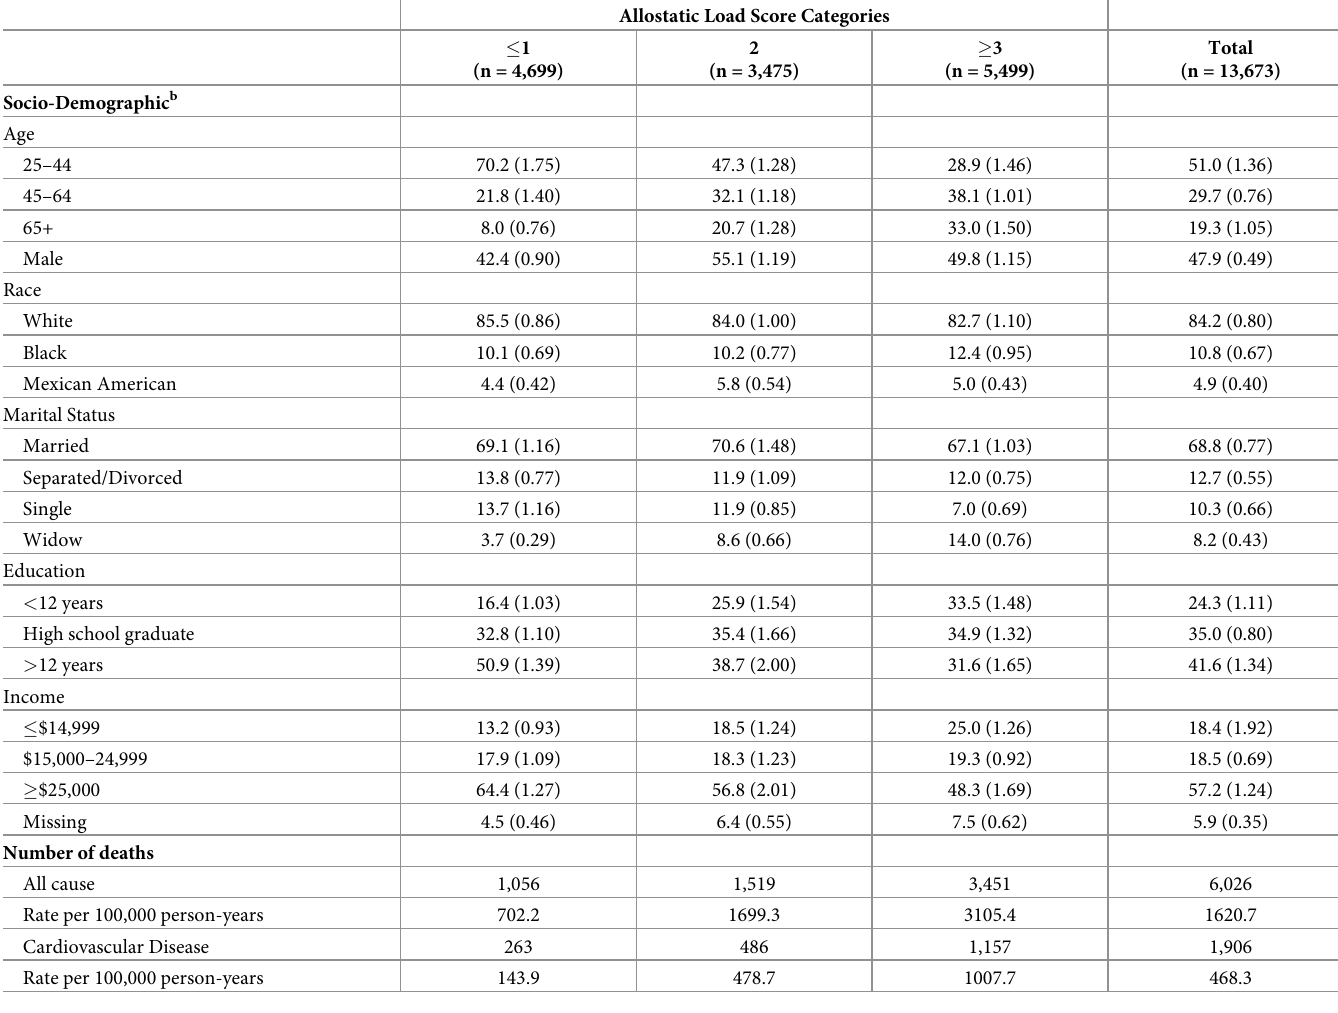
Table 1. Distribution a of selected socio-demographic and health-related characteristics according to allostatic load categories for adults 25 years of age or older: NHANES III-Linked Mortality File, 2015. Allostatic Load Score